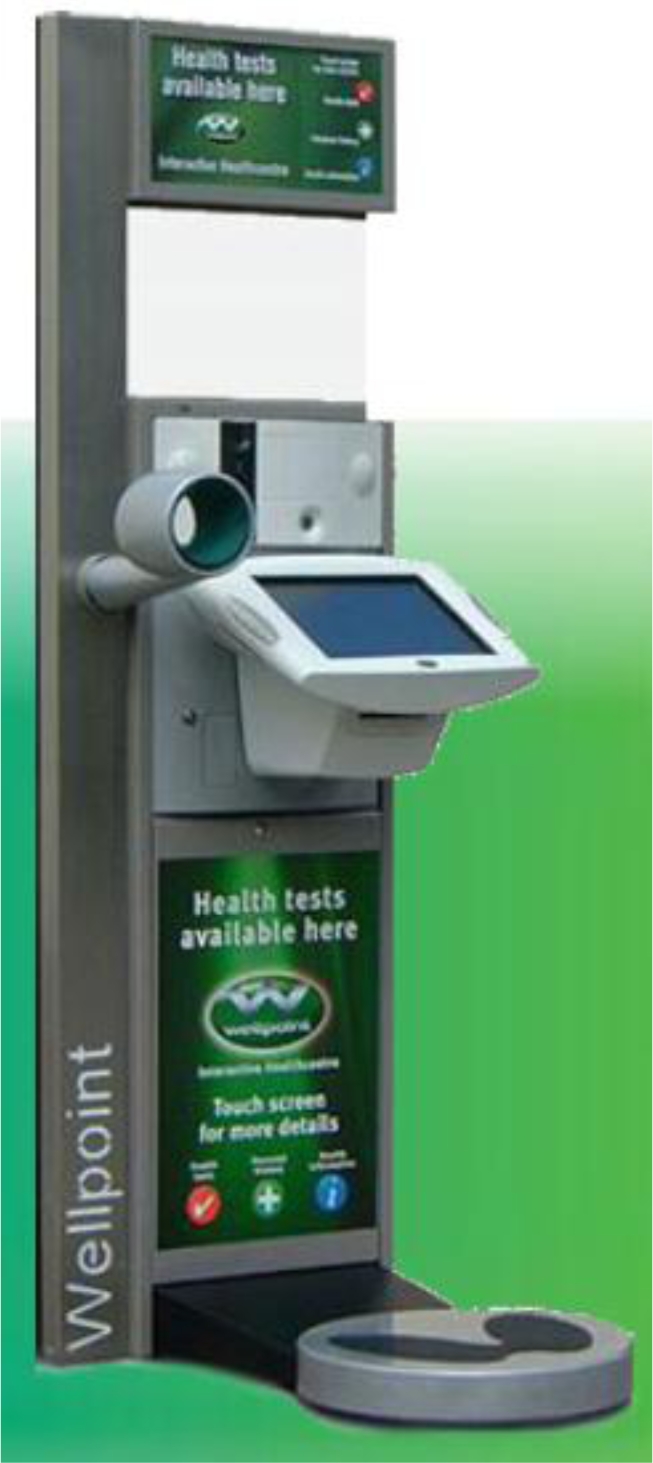
Wellpoint kiosk.